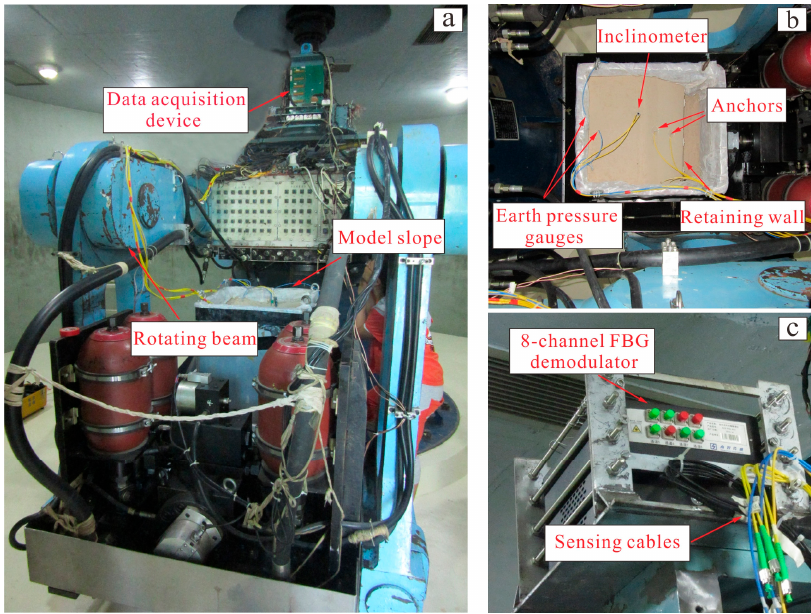
Figure 7. Centrifugal model test ( a ) Photograph of the centrifuge ( b ) Model slope installed on the centrifuge ( c ) Data acquisition device.